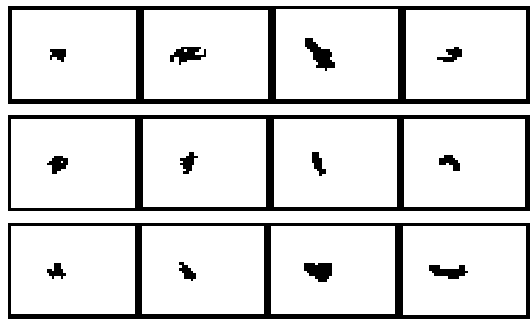
Figure 6. Images of particles larger than 100 μ m taken by built-in camera in Qicpic.